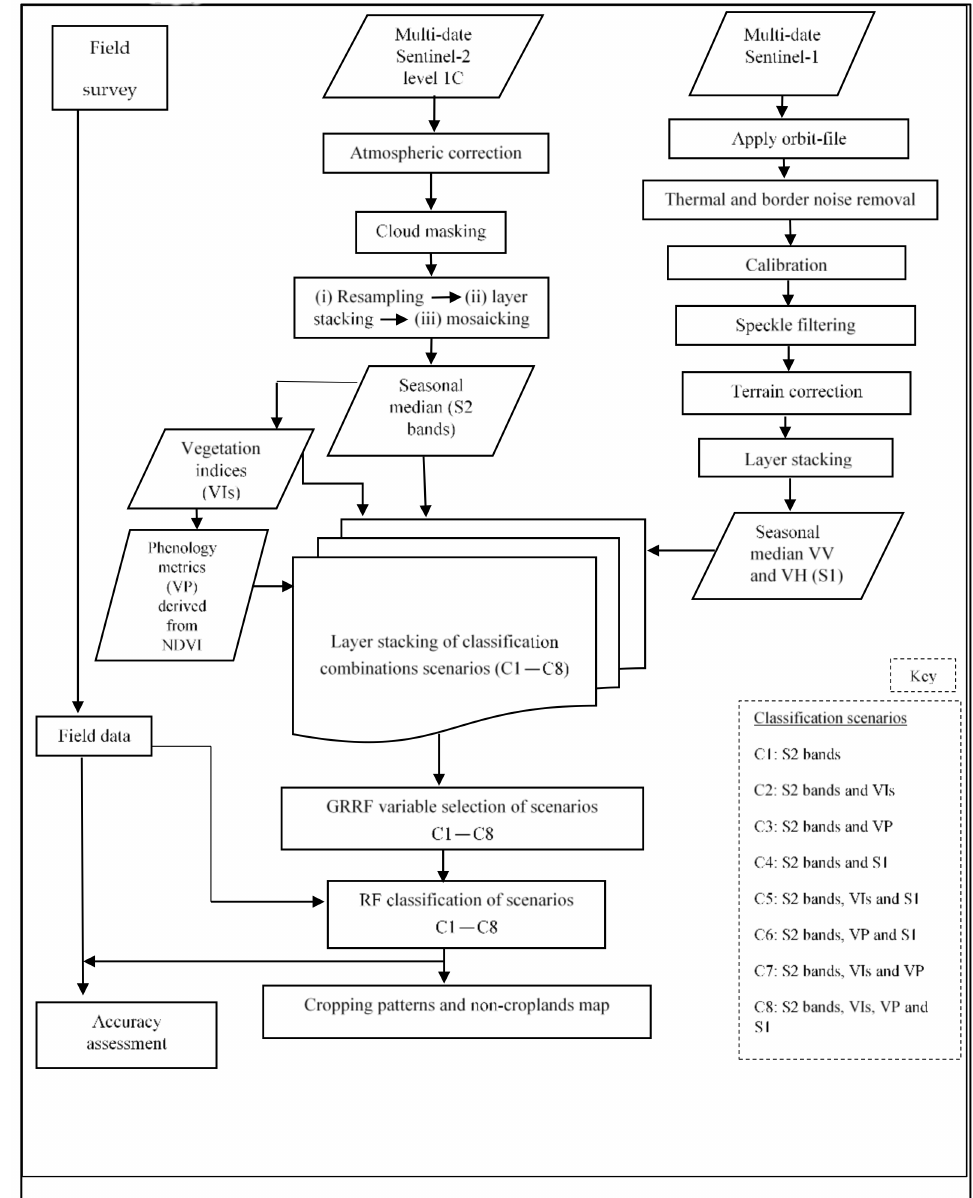
Figure 2. Workflow diagram of the methodology adopted for cropping pattern classification. NDVI is normalized difference vegetation index, GRRF is guided regularized random forest, RF is ran- dom forest, VV is the vertical transmit and vertical receive, and VH is the vertical transmit and horizontal